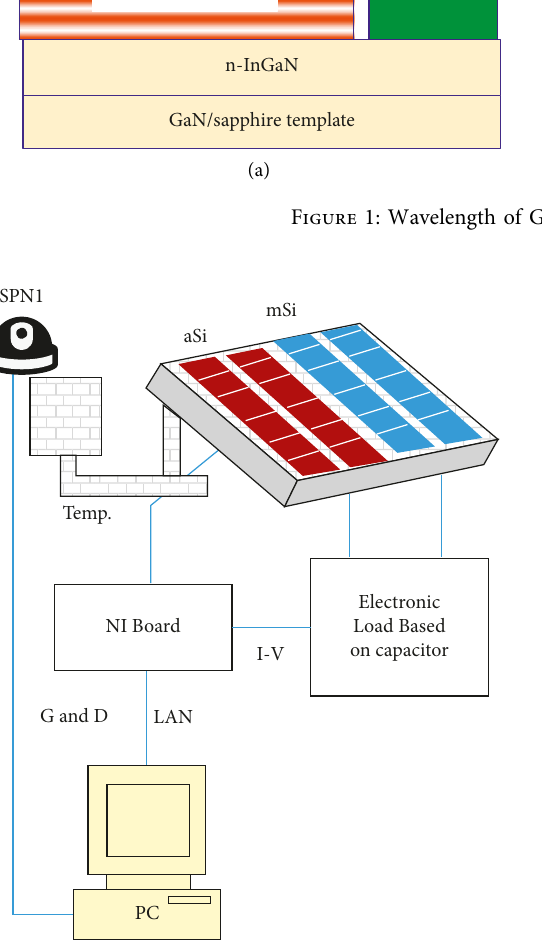
Figure 2: Voltage and current characteristics of mSi and aSi using the capacitor technique.